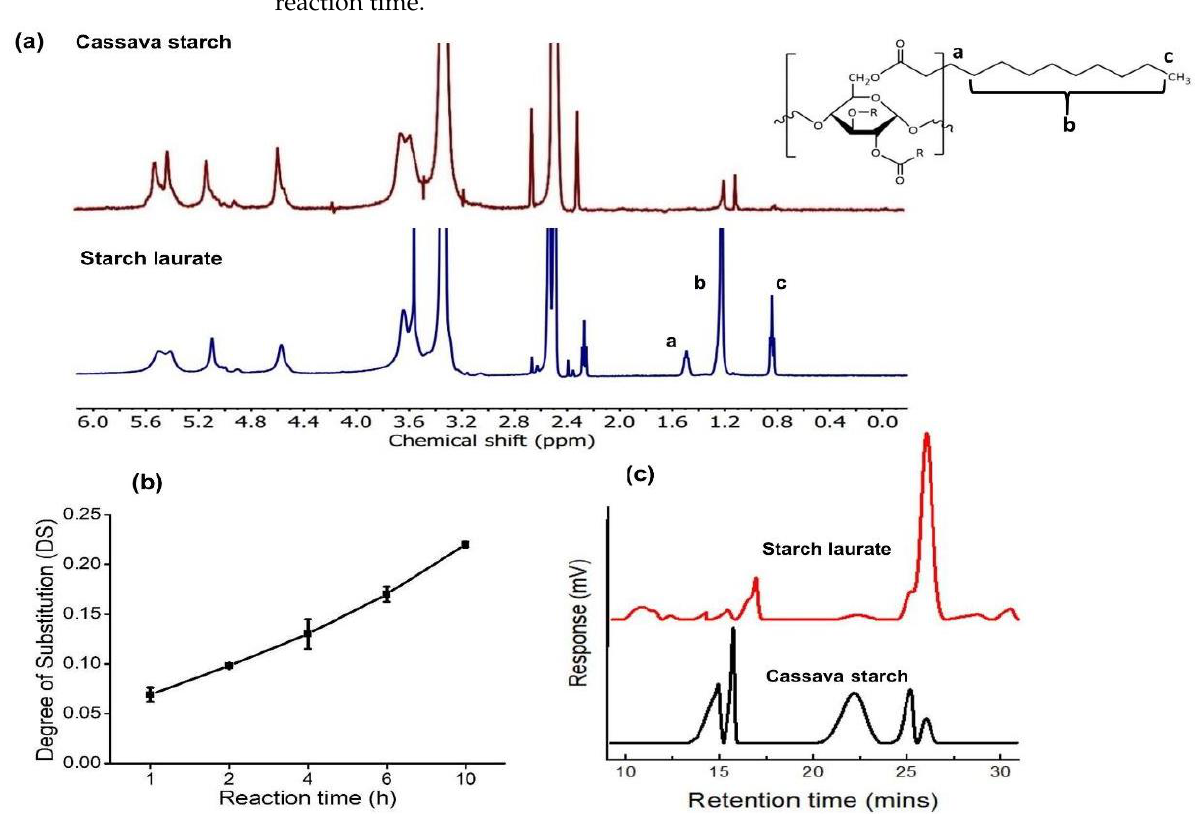
Figure 2. ( a ) 1 H-NMR spectra of native cassava starch and starch laurate (10 h) while a, b, c denoted the characteristic protons on starch laurate, ( b ) degree of substitution (DS) of starch laurates with the reaction times, and ( c ) aqueous GPC thermograms of cassava starch and starch laurate (10 h).